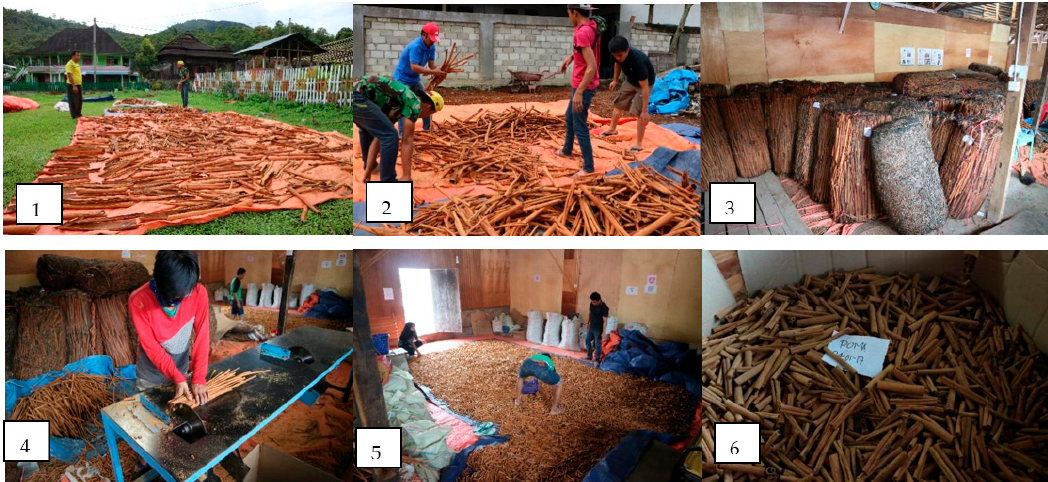
Figure 10. TAKTIK post-harvesting practice following the GI Koerintji handbook guideline.